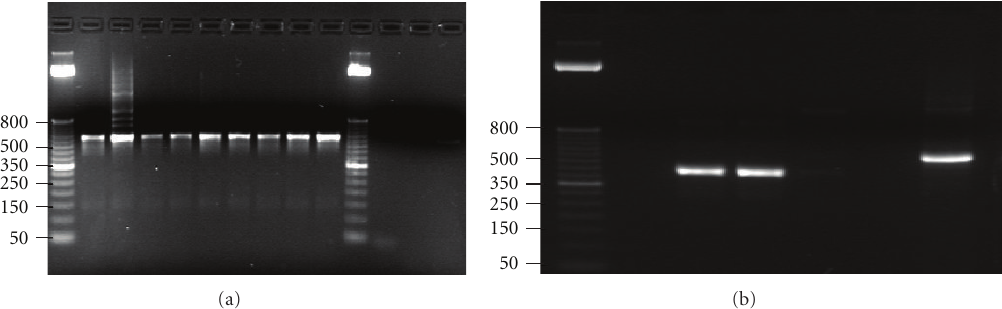
Figure 3: Gel electrophoresis showing the DNA-ladder on each end with the all urine samples (a) and plasma samples (b) with the DNA- ladder on the left side showing similarity between of NCCR region size in each